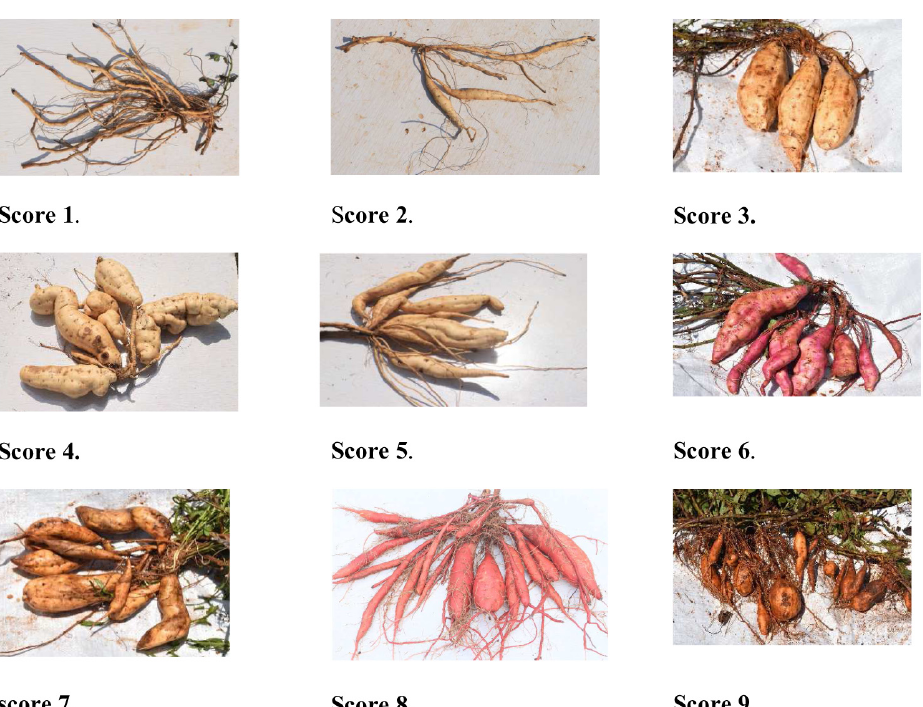
Figure 1. A 1 to 9 scoring scale for continuous storage root formation and bulking in which score: 1 = no visual detectable storage root initiation (SRI) and no visually detectable bulking; 2 = Storage root formation and bulking detectable; 3 = no visually SRI and has unclear levels of bulking; 4 = distinct SRI and 2 clear levels of bulking; 5 = distinct SRI and 3 clear levels of bulking; 6 = distinct SRI and 4 clear levels of bulking; 7 = distinct SRI and 5 clear levels of bulking; 8 = distinct SRI and 6 clear levels of bulking; and 9 = distinct SRI and 7 clear levels of